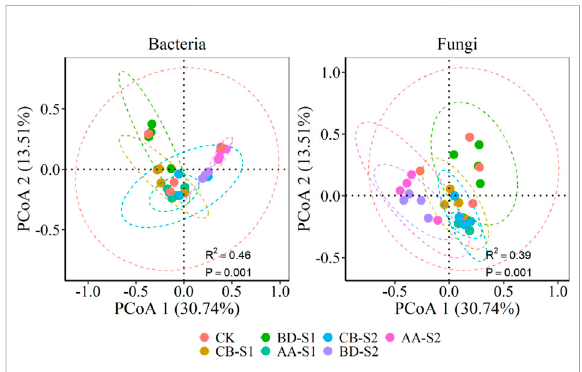
FIGURE 2 The NMDS ordinations of bacterial and fungal communities (OTU level) for bare soils and rhizosphere soils of three metal- tolerant plants at S1 and S2. Individual data points with different colors represent individual soil samples. Analysis of similarity (ANOSIM) test showing the difference of bacterial and fungal community structure among bare soils and rhizosphere soils of three metal-tolerant plants at S1 and S2. CB, BD and AA respectively represented C. breviculmis , B. davidii , and A. annua . S1, sample site on the zinc smelter waste heap; S2, sample site around the zinc smelter waste